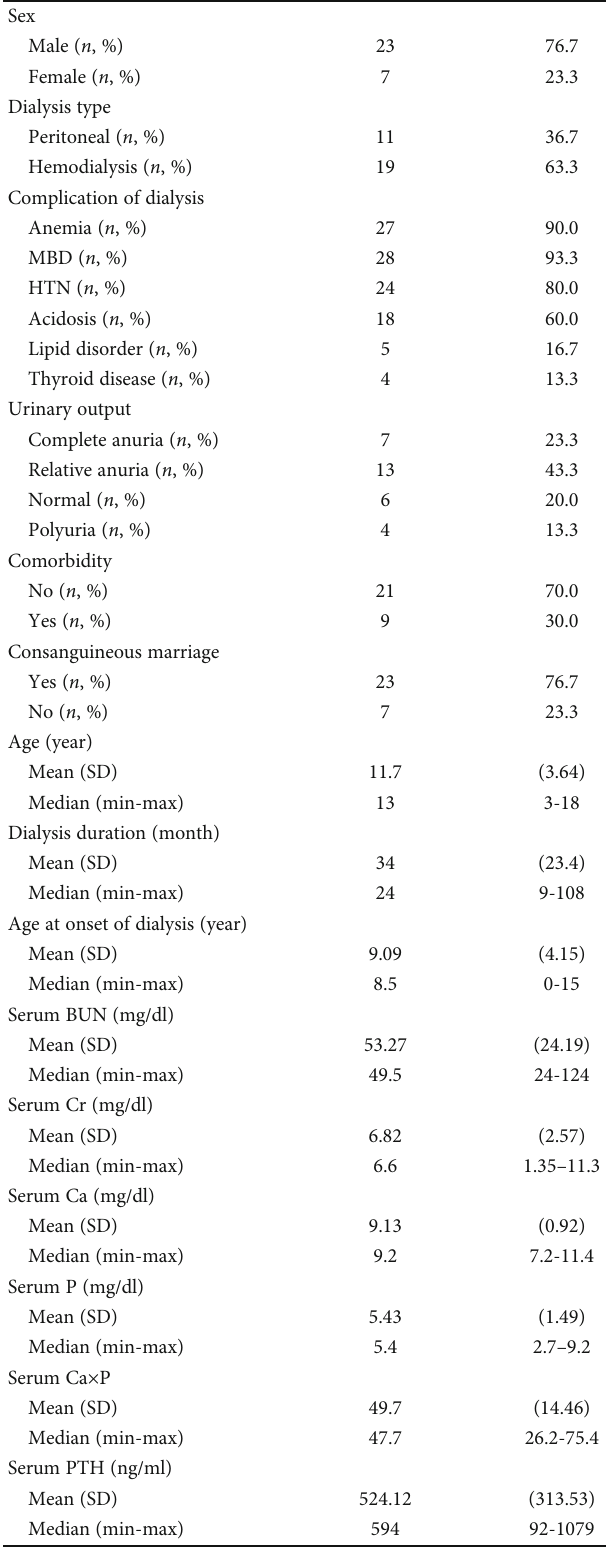
Table 1: Clinical characteristics and laboratory data of chronic kidney disease (CKD) children with